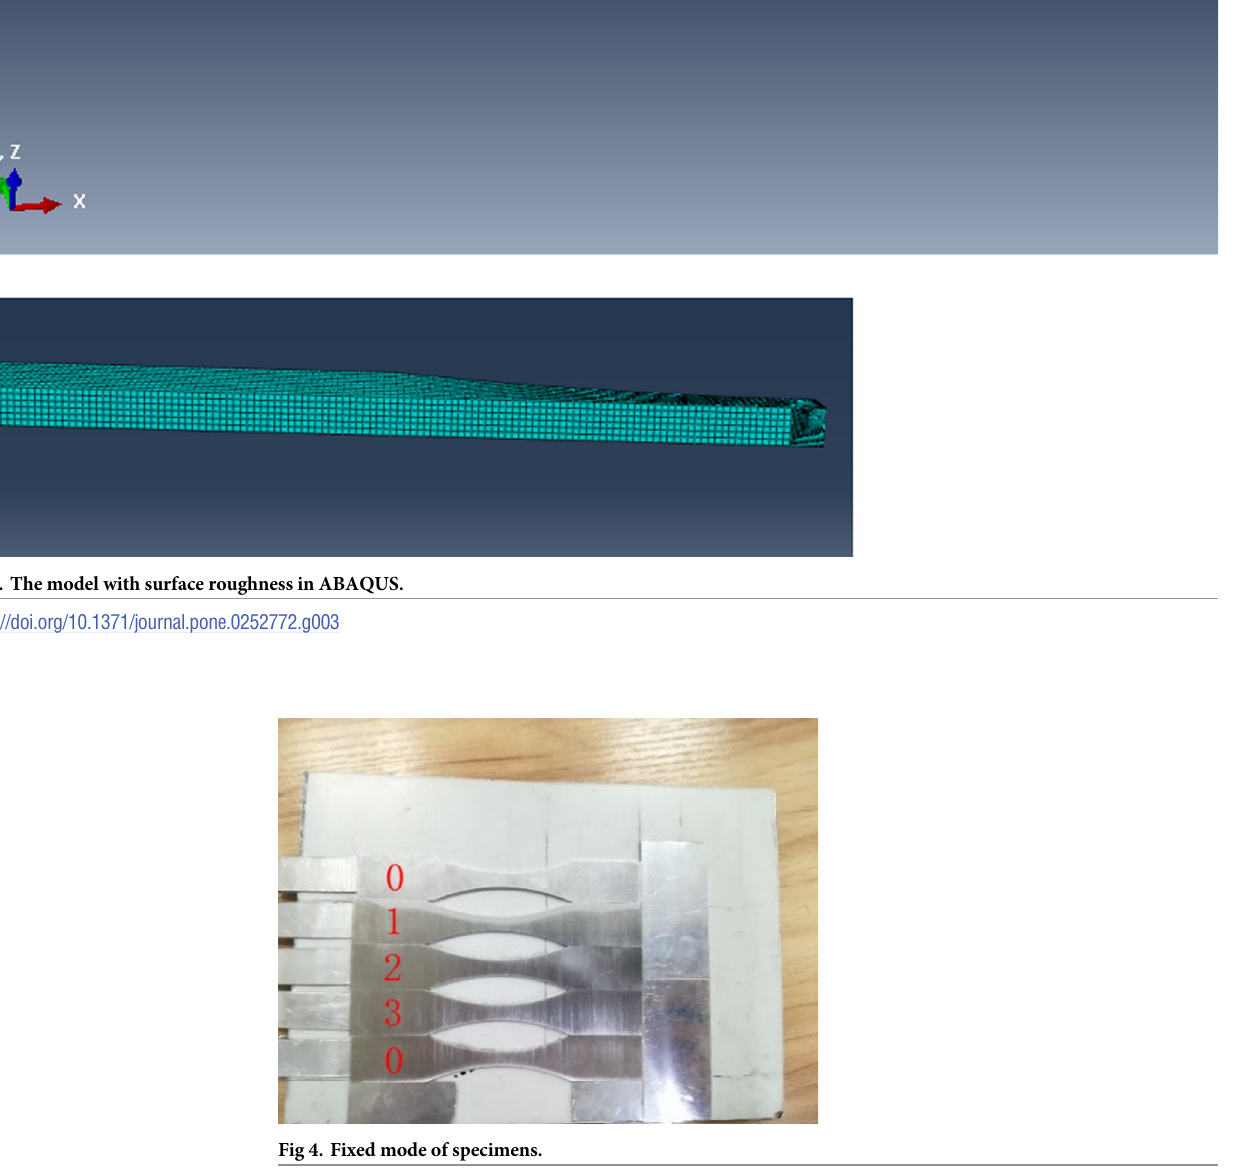
PLOS ONE | https://doi.org/10.1371/journal.pone.0252772 June 30,